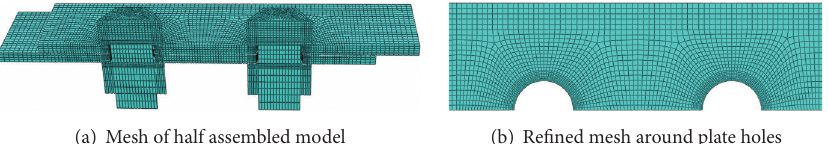
Figure 6: Mesh of the FEM model and refined mesh around holes.